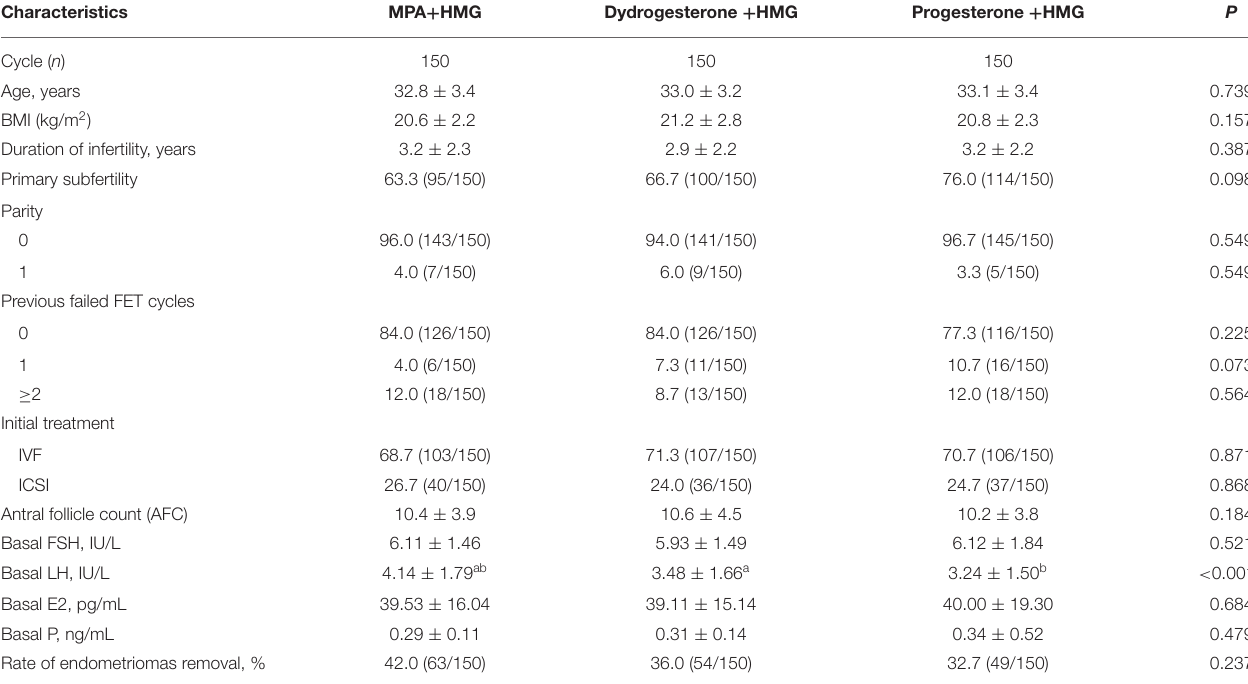
BMI, body mass index; FSH, follicle stimulating hormone; LH, luteinizing hormone; E 2 , estrogen; P, progesterone. a P < 0.05 MPA + hMG vs. Dydrogesterone + hMG. b P < 0.05 MPA + hMG vs. Progesterone +